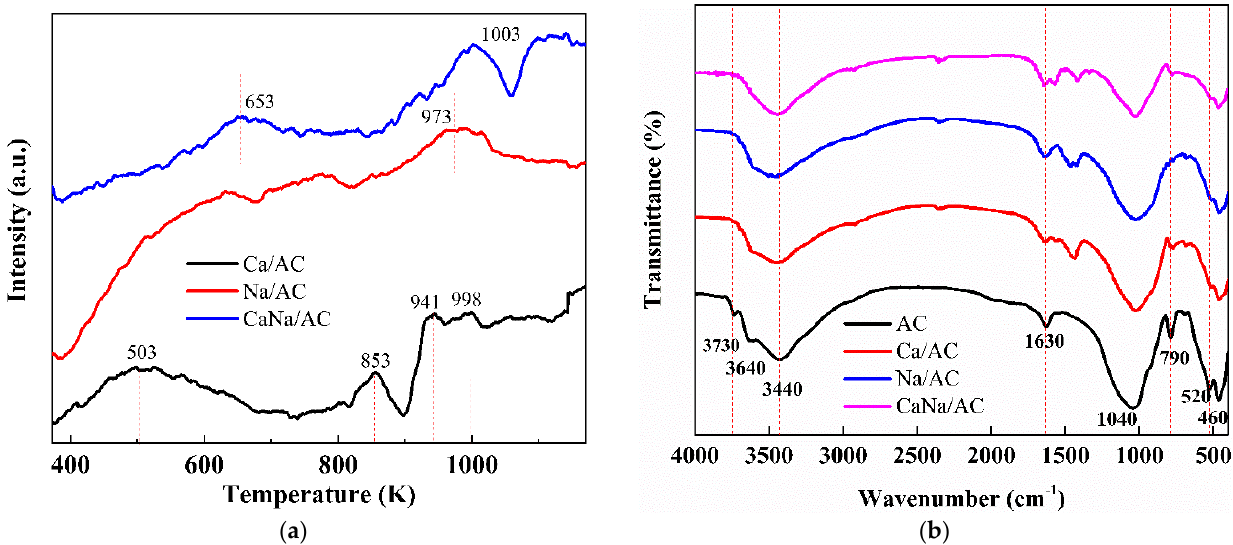
Figure 1. ( a ) CO 2 -TPD profiles of Ca/AC, Na/AC, and CaNa/AC; ( b ) FT-IR spectra of AC, CA/AC, Na/AC, and CaNa/AC.